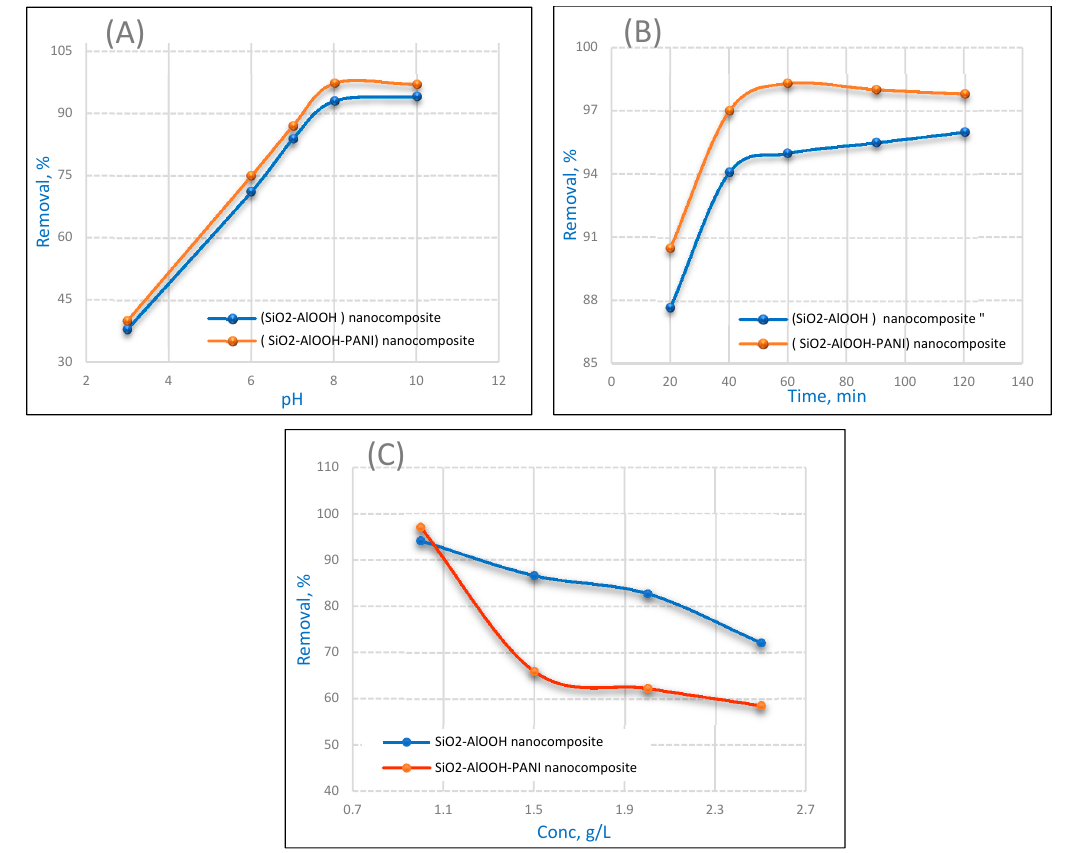
Figure 6. Influences of ( A ) pH, ( B ) contact time, and ( C ) initial Ni concentration, on the adsorption of Ni (II) by 0.3 g/50 mL nanocomposite at a pH of 8 and a contact time of 40 min.